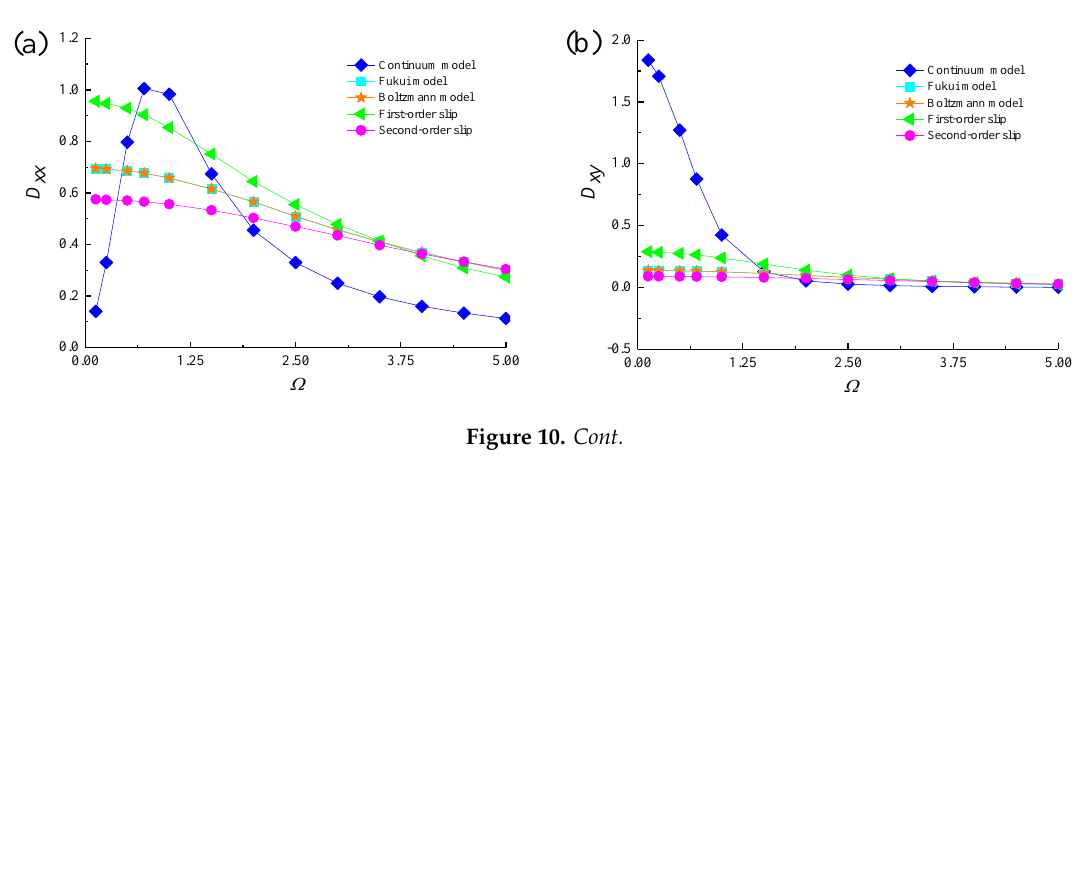
Figure 9. Effect of perturbation frequency Ω on dynamic stiffness coefficients of gas microbearings. ( a ) K xx vs. Ω; ( b ) K xy vs. Ω; ( c ) K yx vs. Ω; ( d ) K yy vs. Ω .